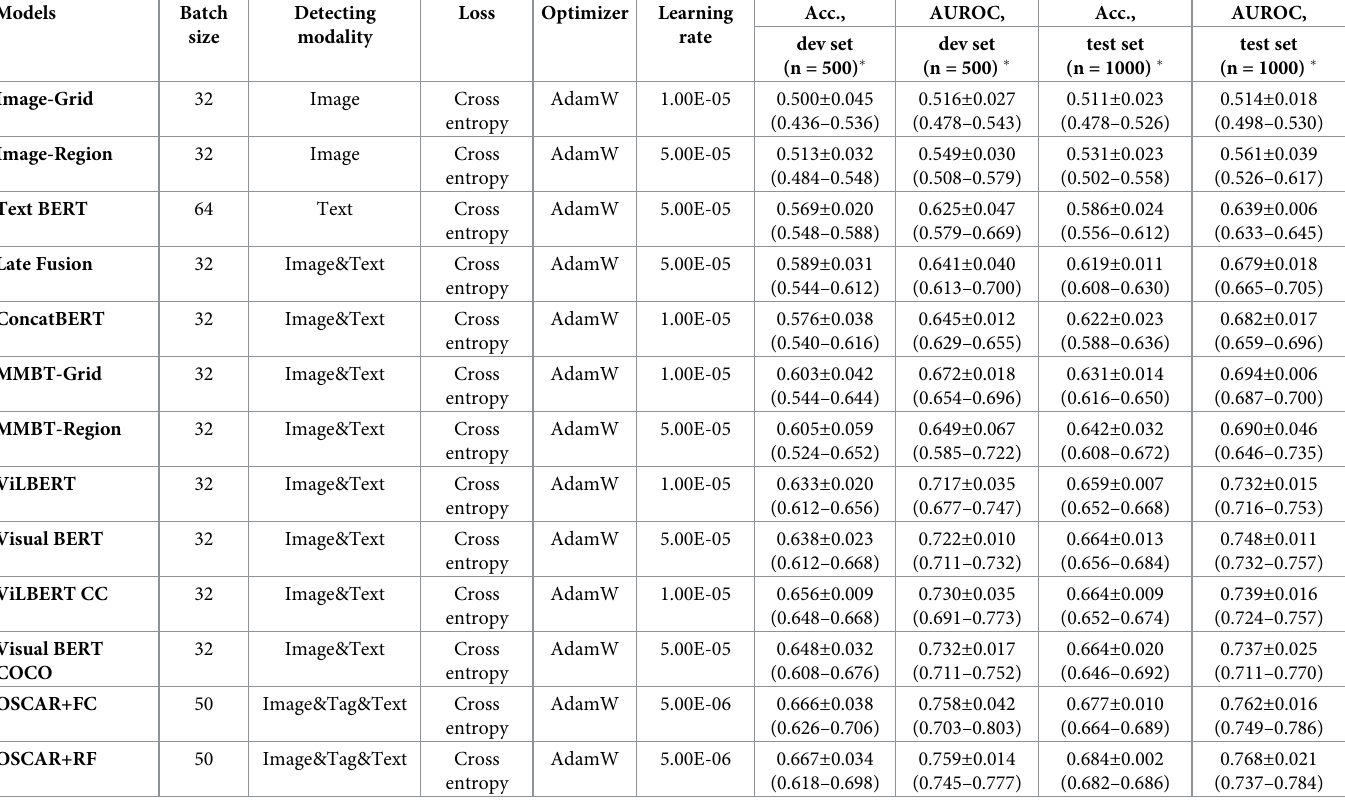
Table 1. Comparisons among our models with other published baselines.